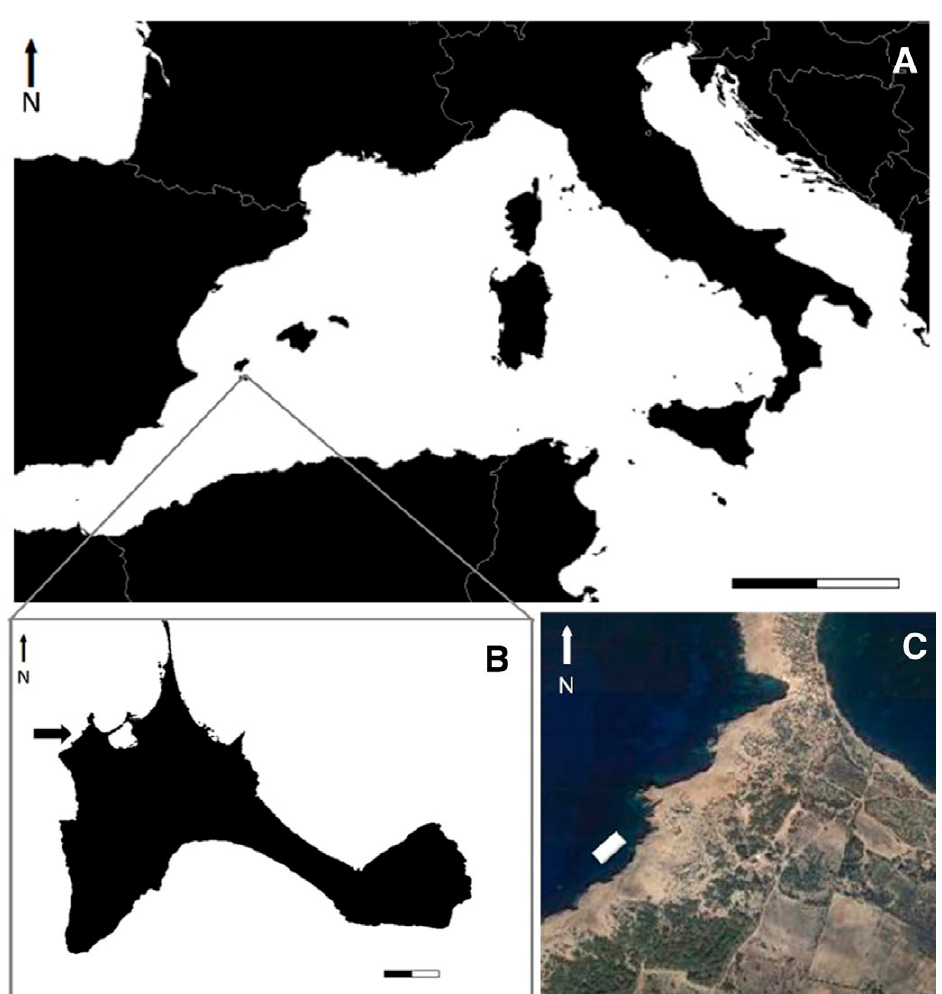
Fig. 1. – A, Western Mediterranean. Scale bar: 500 km. B, arrow indicates the sampling site, Es Banc, located on the northwestern side of Formentera island. Scale bar: 3 km. C, surveyed area of 1150 m 2 displayed as a white frame (source: Google